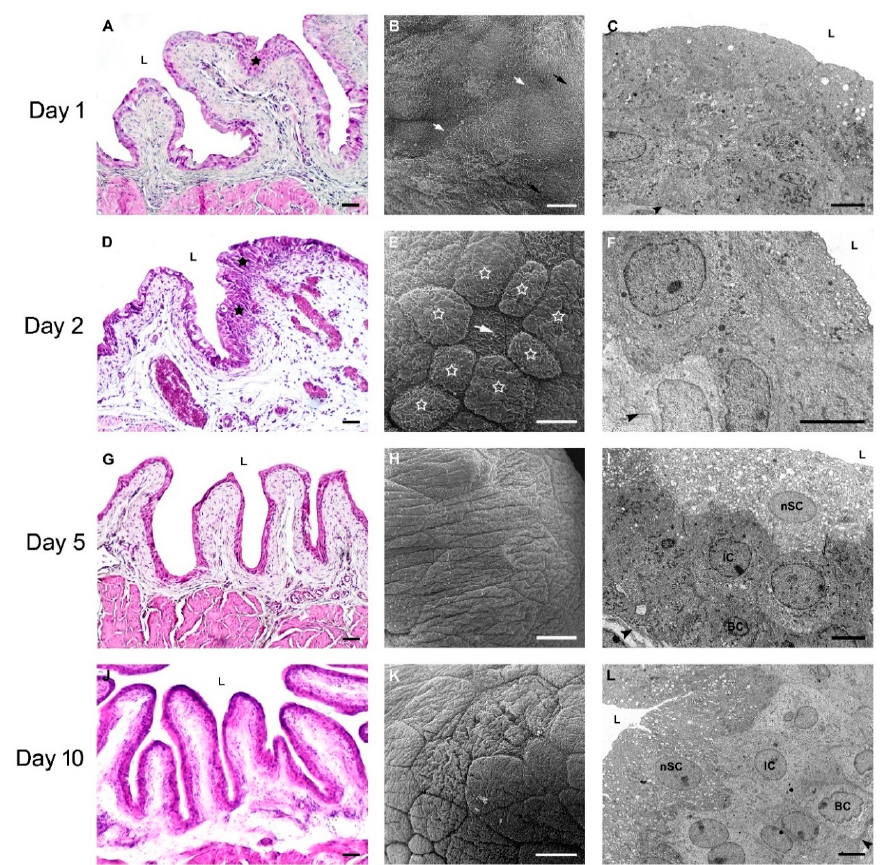
Figure 3. Representative micrographs of the urothelium during regeneration in young mice. On day 1 after chitosan treatment ( A – C ), the urothelium is mostly two-layered with some hyperplastic areas (black star in A ) ( A , C ) and new superficial cells on the surface with microvilli (white arrows) or ropy ridges (black arrows) on the apical surface ( B ). On day 2 after chitosan treatment ( D – F ), the urothelium is three-layered with a few hyperplastic regions (black stars in D ) ( D , F ). New superficial cells are small but at a higher cell differentiation stage with a specifically scalloped apical surface (star frames) or ropy ridges (white arrow) on the apical surface ( E ). On day 5 ( G – I ) and 10 ( J – L ) after chitosan treatment, the urothelium is continually three-layered ( G , I , J , L ). Superficial cells have a specific scalloped appearance of the apical plasma membrane, well-developed tight junctions ( H , K ), and numerous typical fusiform vesicles in the cytosol ( I , L ). ( A , D , G , J ) Hematoxylin and eosin (H&E) staining; ( B , E , H , K ) Scanning electron microscopy; ( C , F , I , L ) Transmission electron microscopy. L-lumen of the urinary bladder, BC-basal cells, IC-intermediate cells, nSC-new superficial cells. Black arrowheads show basal lamina. Scale bars: 100 µm ( A , D , G , J ); 10 µm ( B , E ); 20 µm ( H , K ); 6 µm ( C , F , I , L ).